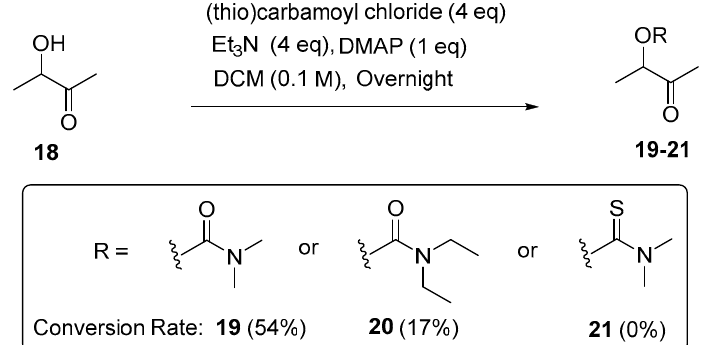
Table 3. Seventy-two hours of antiproliferative activity of carbamoyled 5,7,20- O -trimethylsilybins.